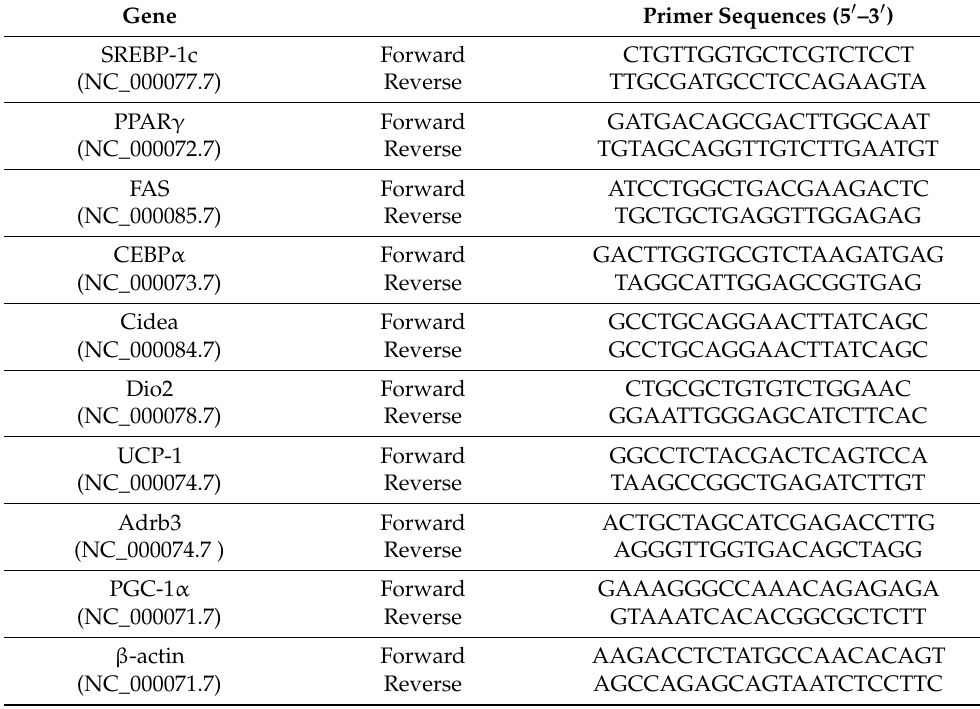
Table 1. Primer sequences used for